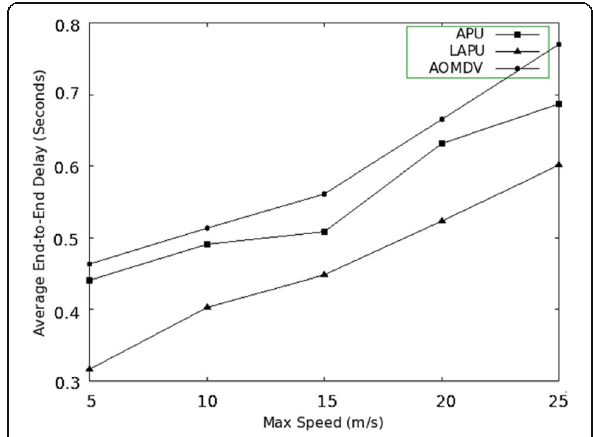
Fig. 5 Average end-to-end delay vs. node mobility